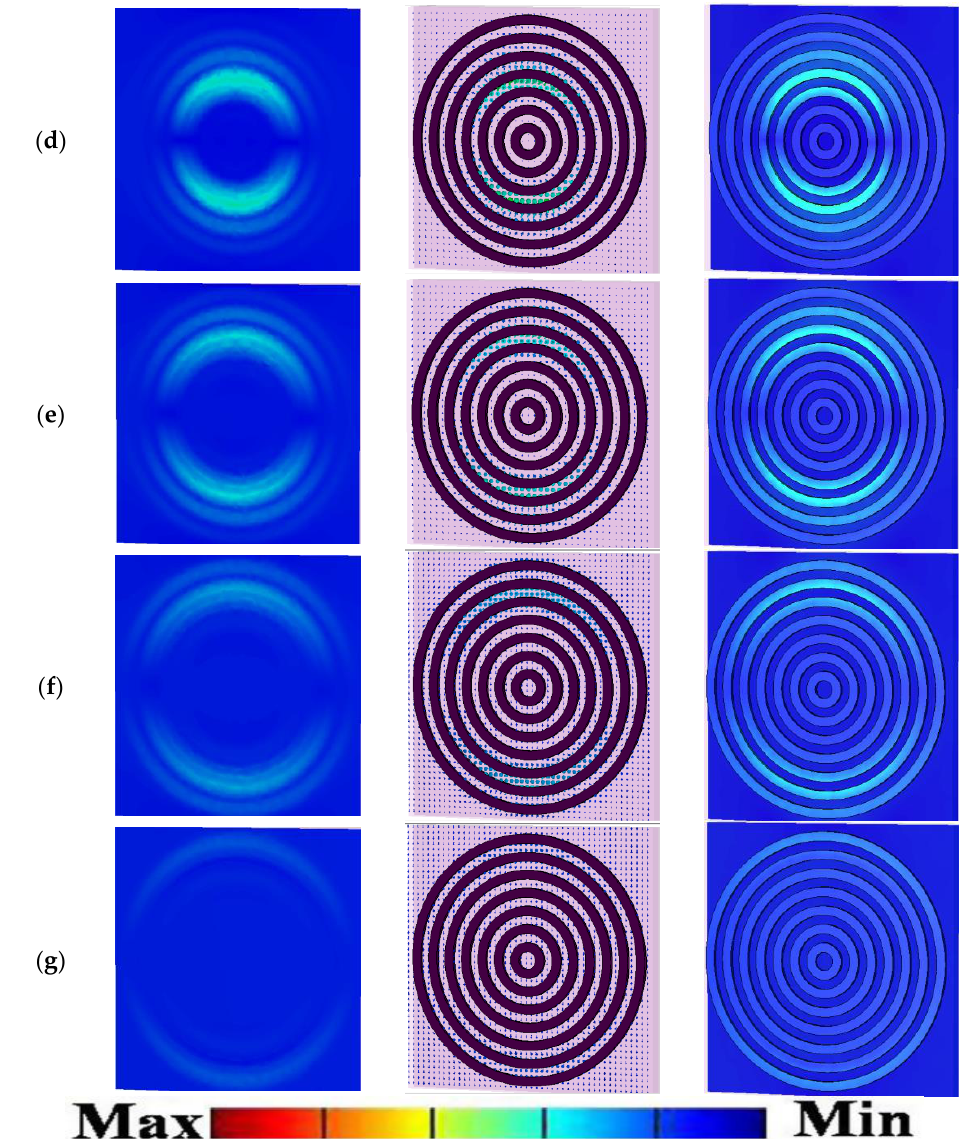
Figure 7. The magnetic field distributions and surface current densities on the top and bottom layer of the proposed microstructure in XY-plane at different resonance frequencies. Column (I) shows electric field distributions at Z = 36 nm. Column (II) shows surface current electric energy densities. Column (III) shows electric field distributions at Z = 25 nm. For unit cell G at frequency of: ( a ) 𝑓 1 = 1.55 THz, ( b ) 𝑓 2 = 0.81 THz, ( c ) 𝑓 3 = 0.53 THz, ( d ) 𝑓 4 = 0.39 THz, ( e ) 𝑓 5 = 0.31 THz, ( f ) 𝑓 6 = 0.25 THz, and ( g ) 𝑓 7 = 0.2 THz.